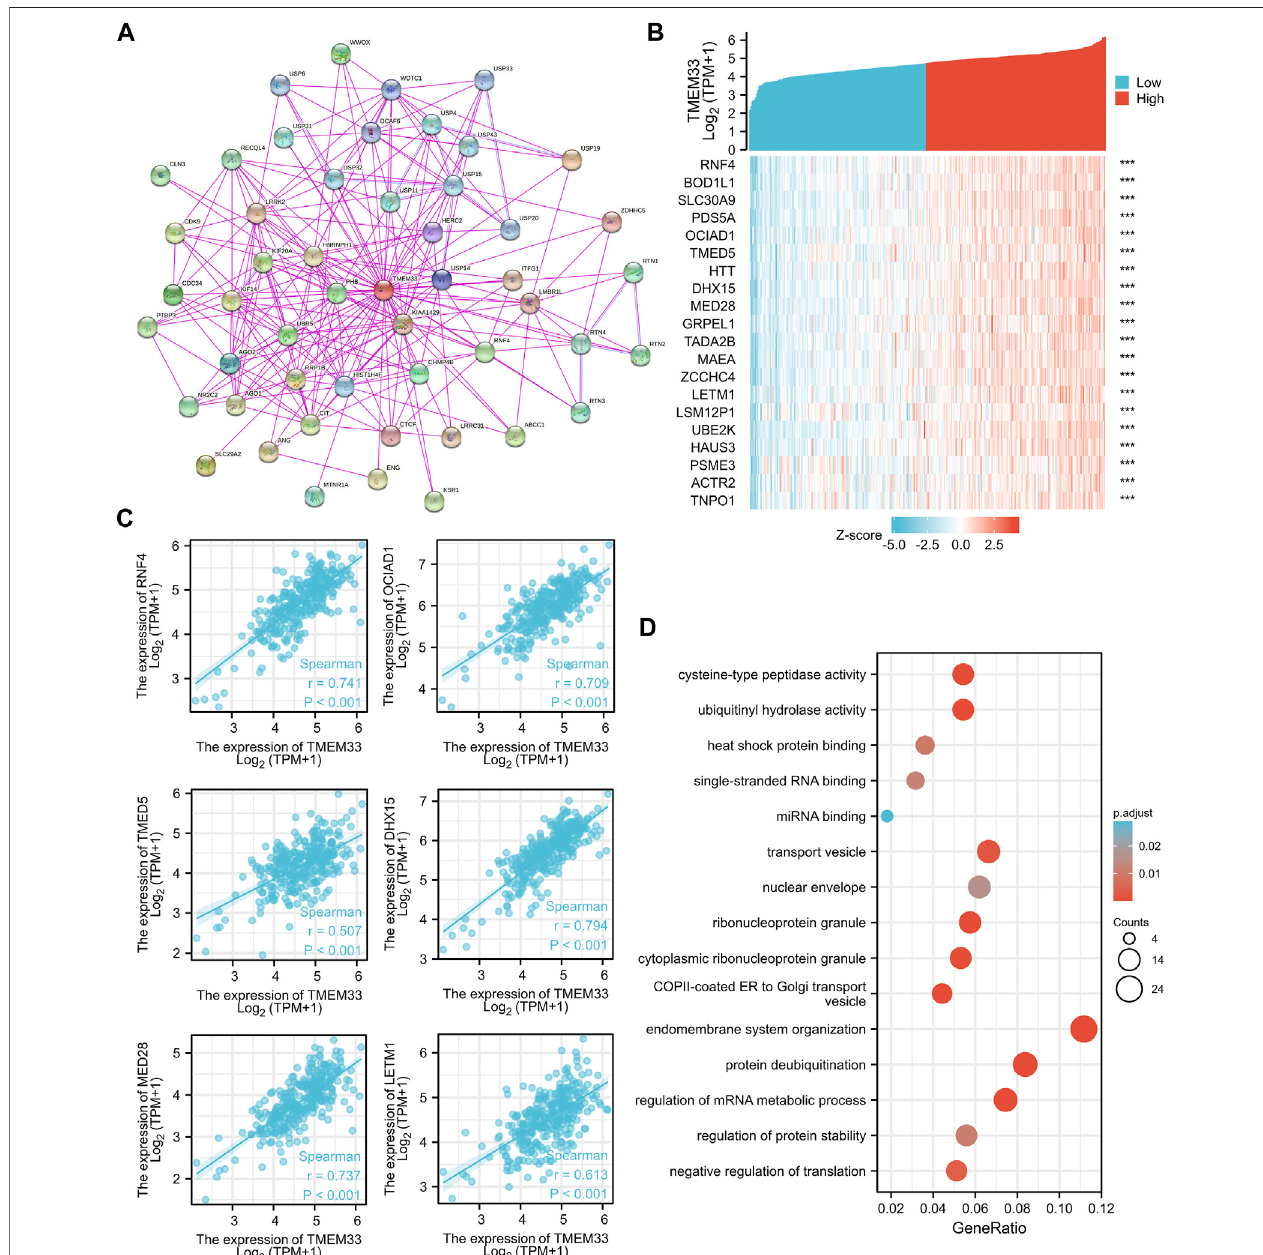
FIGURE 5 | Analysis of TMEM33 correlated genes and PPI network. (A) The visualizing interaction network of TMEM33-binding proteins was generated base on STRING database. Thepurple lineindicates “ experimentally determined ” , the lightblue line refers to “ protein homology ” . (B) Top 20genes positively related toTMEM33 obtained from GEPIA2 were displayed in heatmap. (C) Correlation analysis between TMEM33 expression and screened tumorigenesis-related genes, including RNF4, OCIAD1, TMED5, DHX15, MED28, and LETM1. (D) GO enrichment analysis by TMEM33-similar and interacted genes. *** p < 0.001.